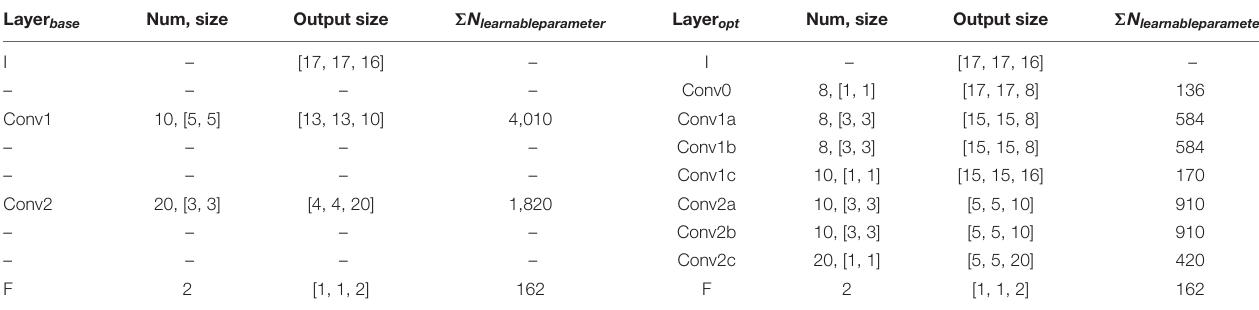
TABLE 2 | Network model parameters corresponding to Figure 2 . Layer base